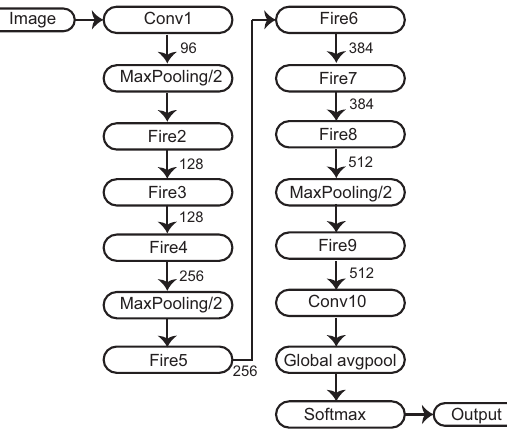
Figure 4. SqueezeNet model